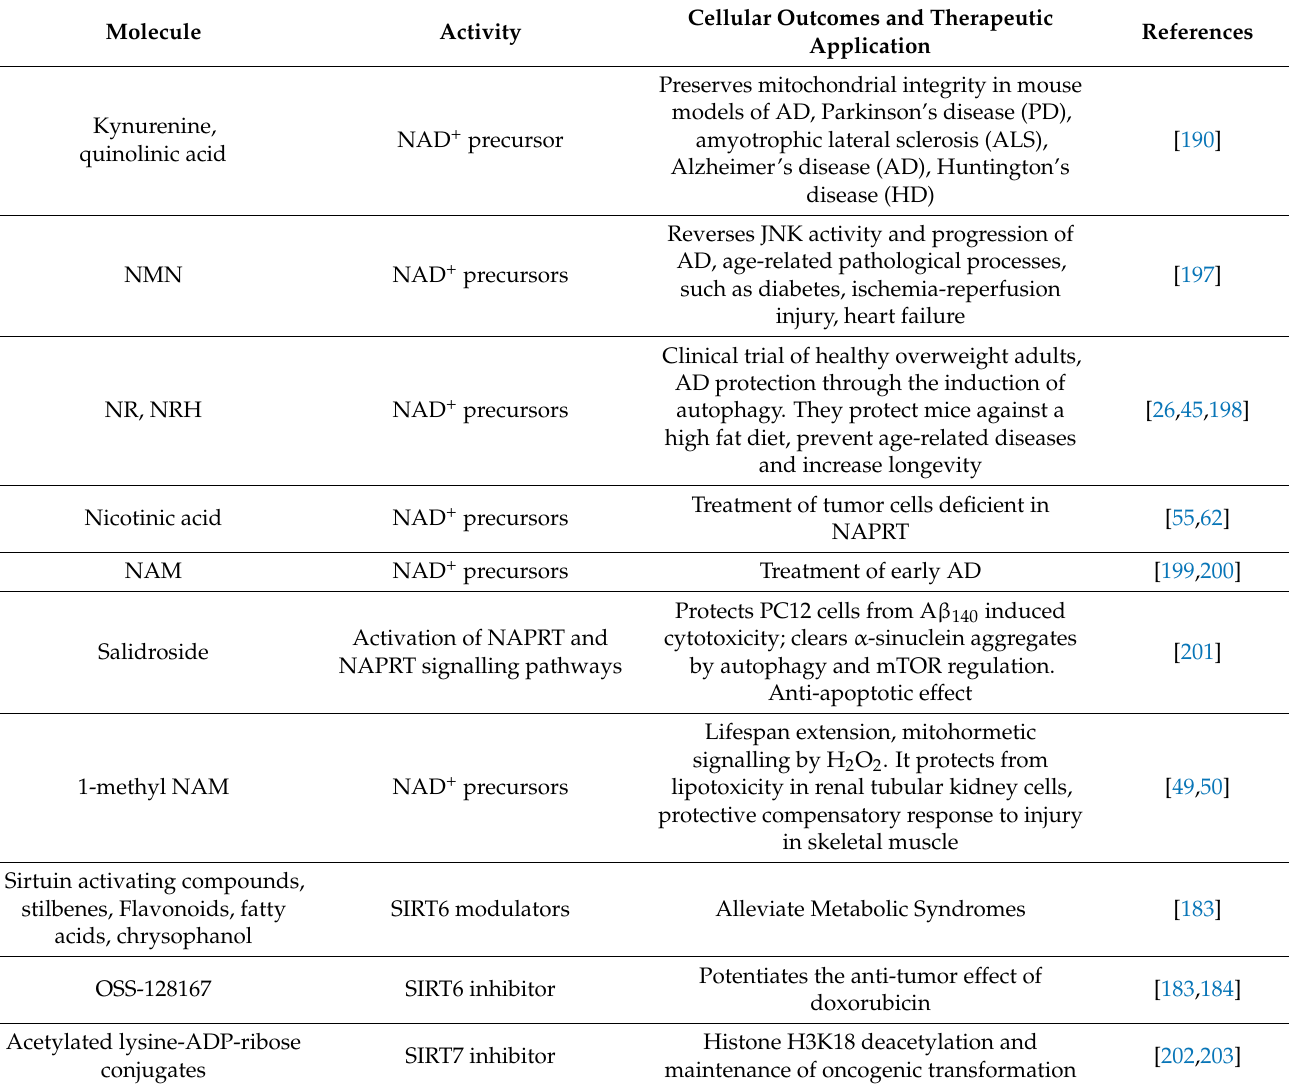
Table 4. NAD+ precursors, NAD+ salvage enzyme activators, and Sirt regulators and inhibitors with therapeutic potential. Cellular Outcomes and Therapeutic Molecule Activity